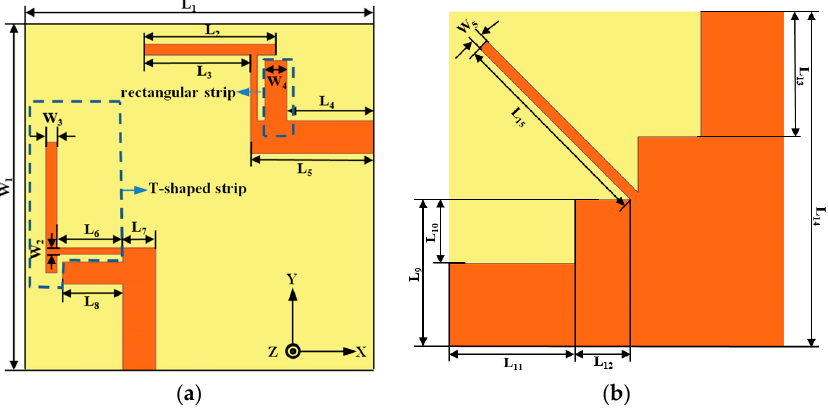
Figure 1. Configuration of the proposed antenna ( a ) top view; ( b ) bottom view.